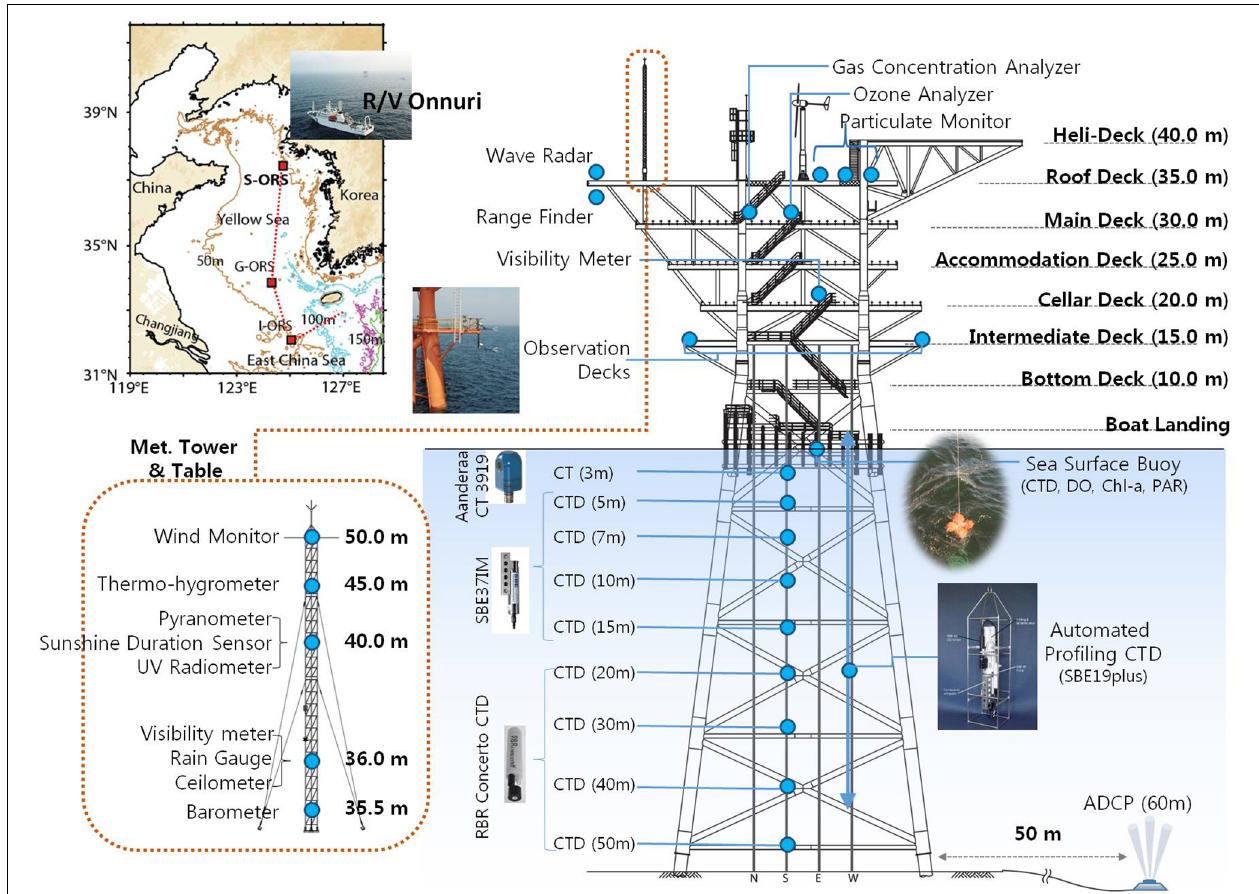
FIGURE 1 | Specification and major observation sensors of the Socheongcho Ocean Research Station (S-ORS), with its geographic location in the Yellow Sea (the upper left-hand map). The red dotted line on the map shows the cruise route of the research vessel during an annual field trip via three KORS, i.e., the S-ORS, the Gageocho Ocean Research Station (G-ORS), and the Ieodo Ocean Research Station (I-ORS) in summer.